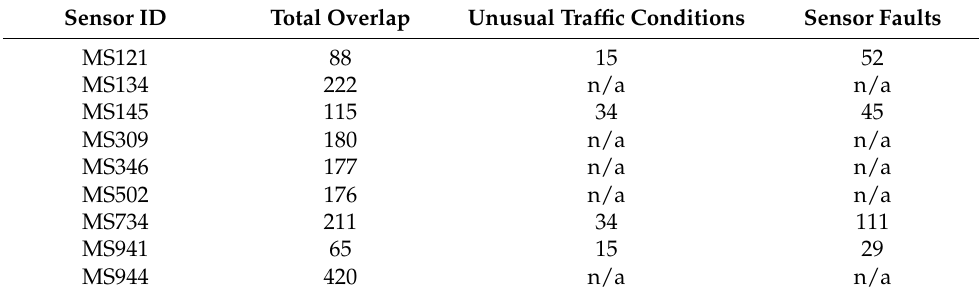
Table 6. Comparison of STL decomposition and isolation forest anomaly detection